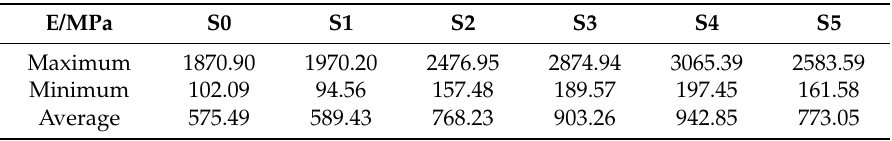
Table 3. The Young’s modulus of phase-change microcapsules (microPCMs) incorporated with different amounts of